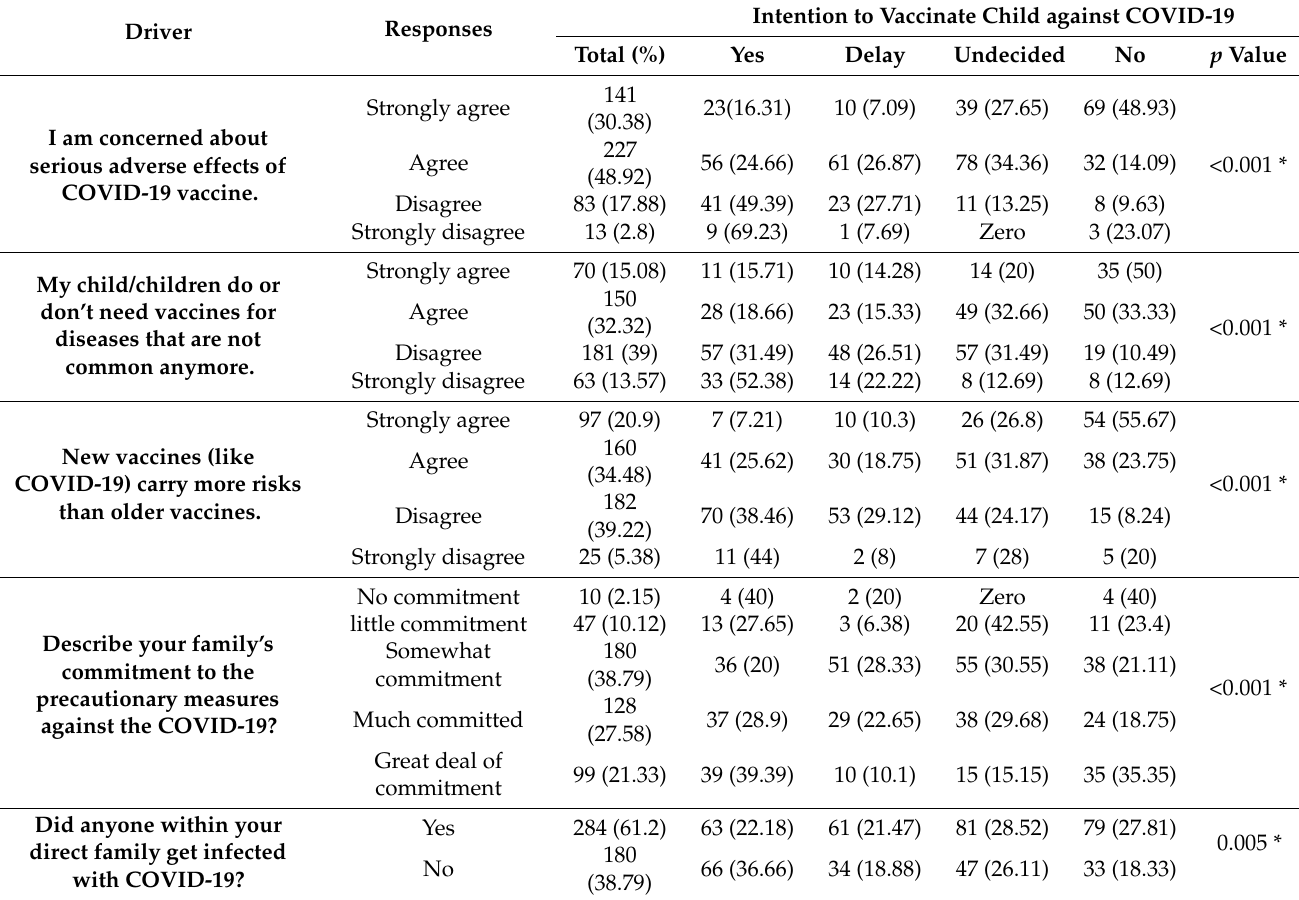
Table 4. Drivers of parental willingness to vaccinate their children against